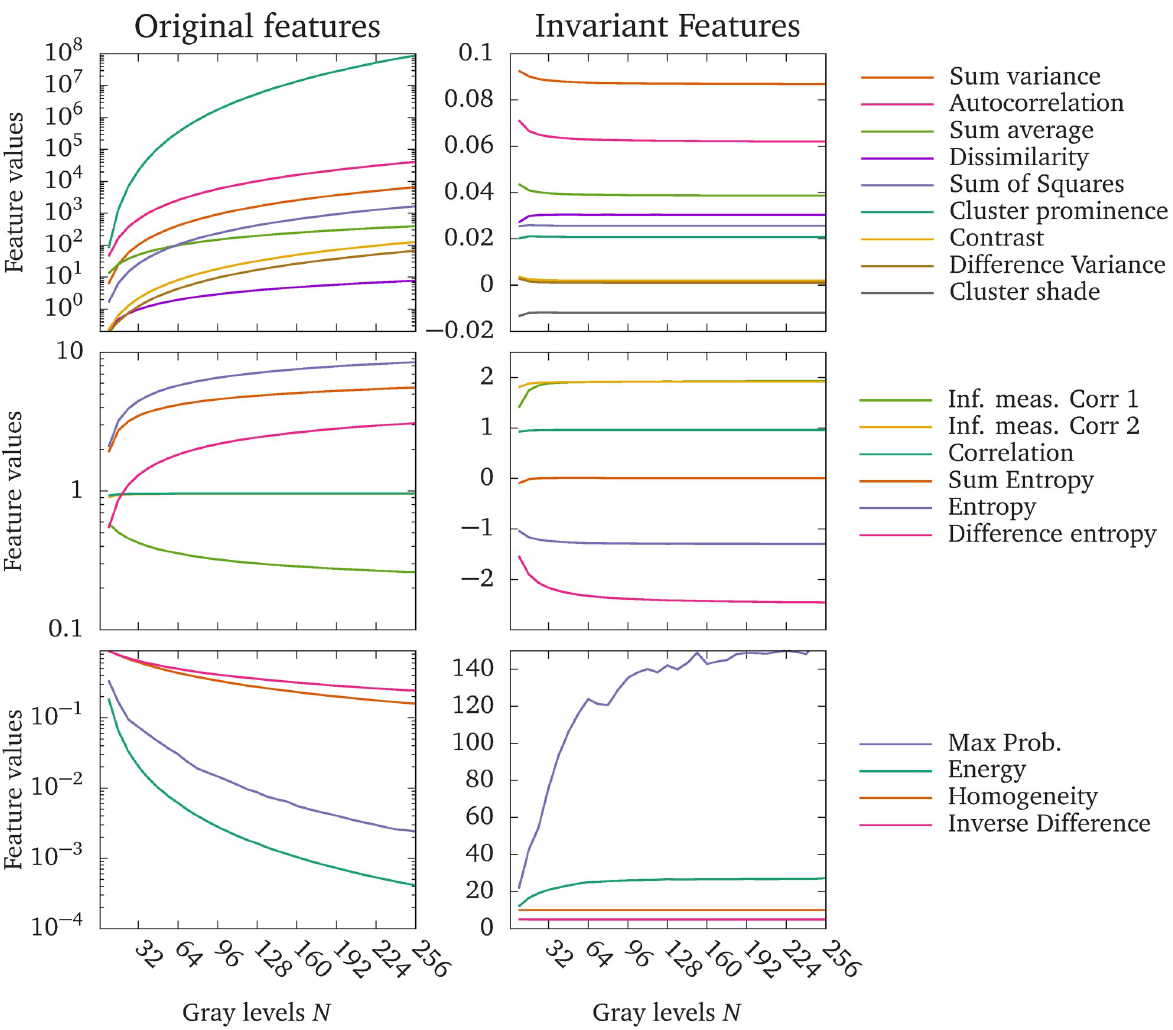
Fig 5. The original Haralick feature values, and the proposed invariant feature values. Texture feature values computed from a benign glandular structure in the gland dataset. The upper left plot shows the original Haralick features that increase rapidly with the number of gray-levels. The middle left plot shows original Haralick features that increase modestly, or reach a plateau with increasing number of gray-levels. The bottom left plot shows original Haralick features that decrease with increasing number of gray-levels. The right column shows the corresponding invariant features. Note that the original features are plotted on a log-scale to accommodate the wide range of values. The Information measure of Correlation 2 and Correlation overlap in the original features. The Information Measure of Correlation 1 is negative in the original features, but the absolute values are displayed in the graph to accommodate the log scale.